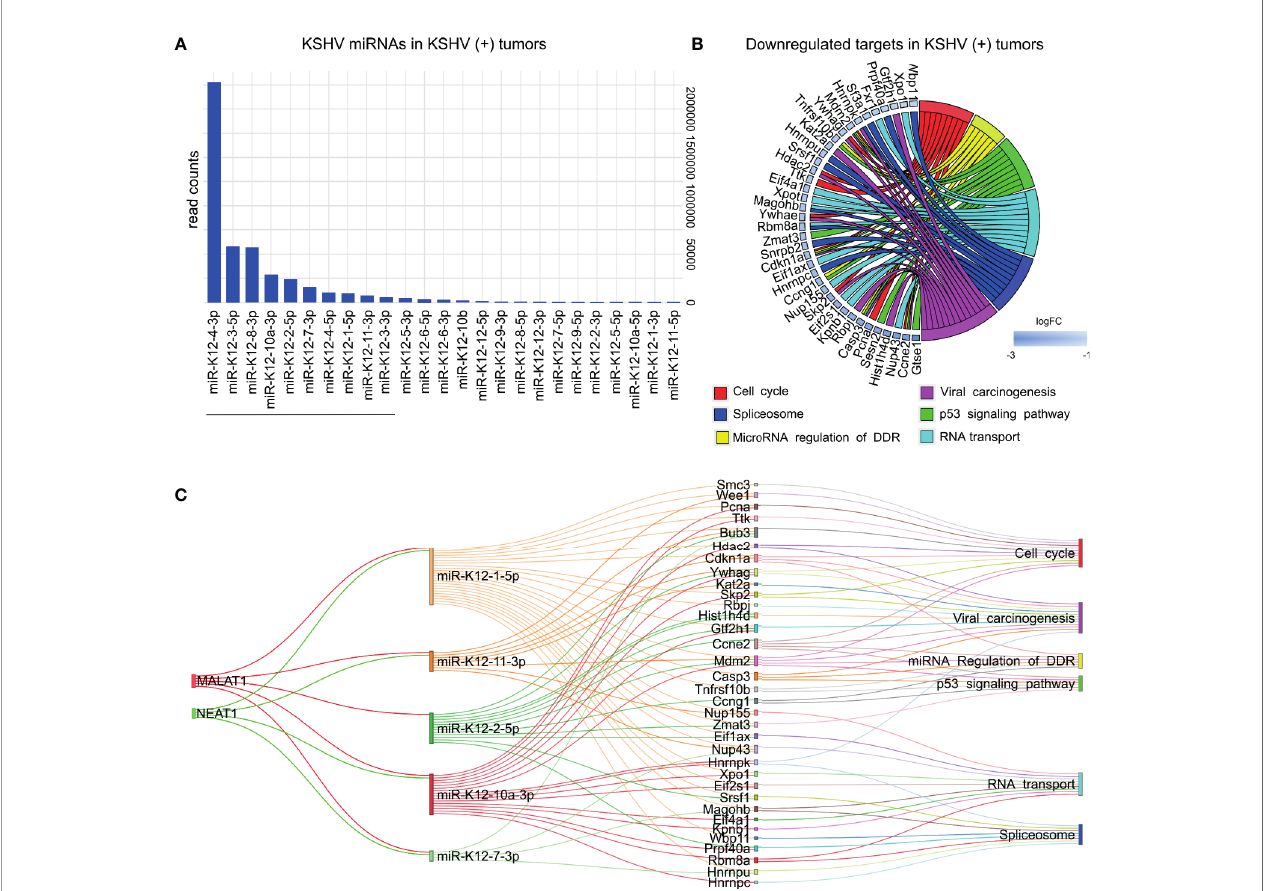
FIGURE 6 | KSHV miRNAs expression analysis in KSHV (+) tumors. (A) Bar plot of KSHV miRNAs relative abundance by showing counts in KSHV (+) tumors. Underlined are shown the top ten most frequent miRNAs (B) Pathway analysis showing host downregulated target genes of the ten KSHV miRNAs most abundant in KSHV (+) tumors. (C) Network relationship among lncRNAs, KSHV microRNAs, mRNAs and their enriched